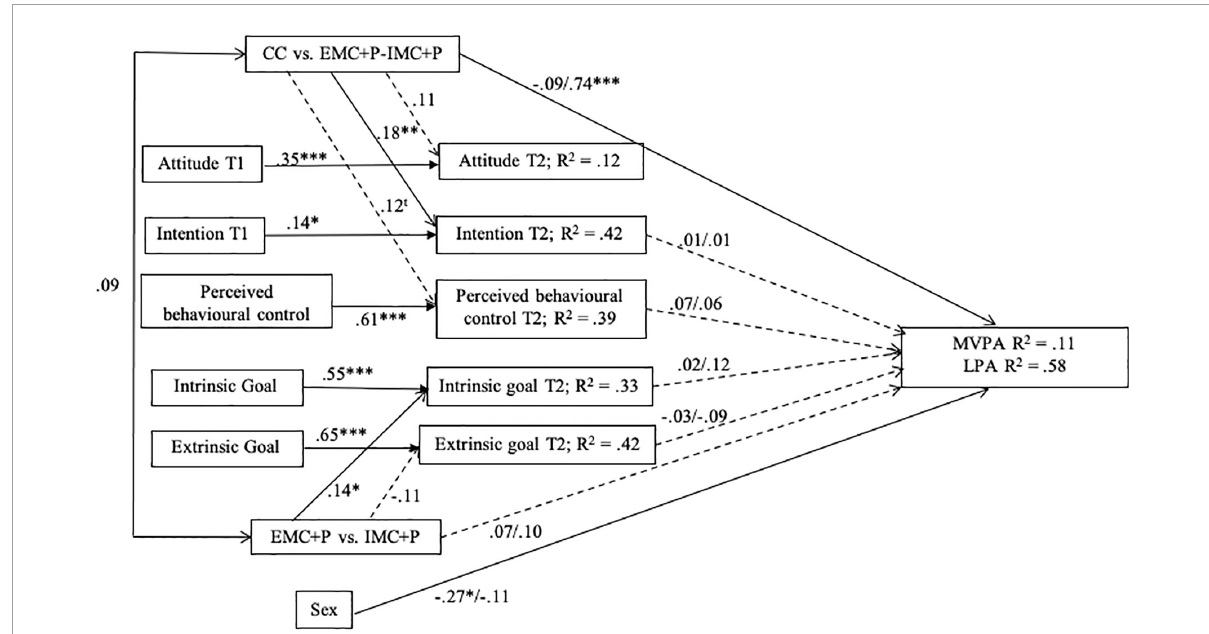
FIGURE2 Mediational models. When two indices are noted on the path analysis, the first number corresponds to MVPA, and the second one to light physical activity. Sex is coded as 1 = male and 2 =